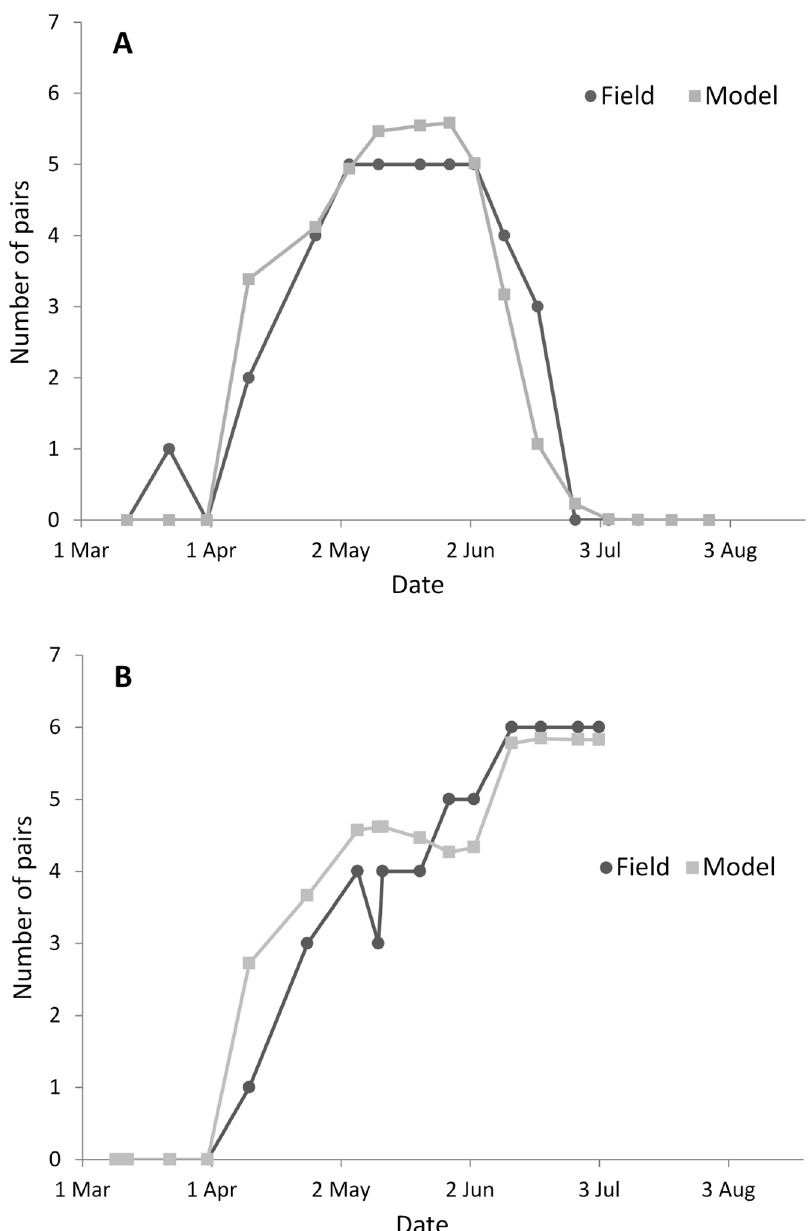
Figure 5. Comparison of the seasonal distribution of the number of territorial pairs observed in the Kalø study area on fields without (A) and with (B) scrapes, and those predicted by the ALMaSS skylark model.